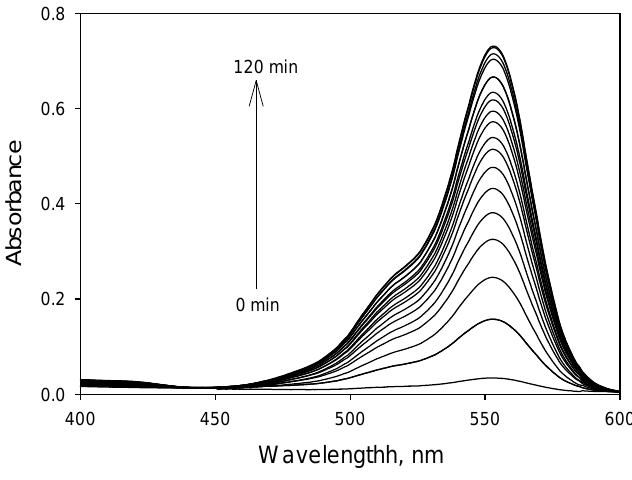
Figure 6. Absorbance spectra of RECM (50 µM) in CH 3 CN in the presence of 30 µM of Cu 2+ in 0–120 min after mixing together.